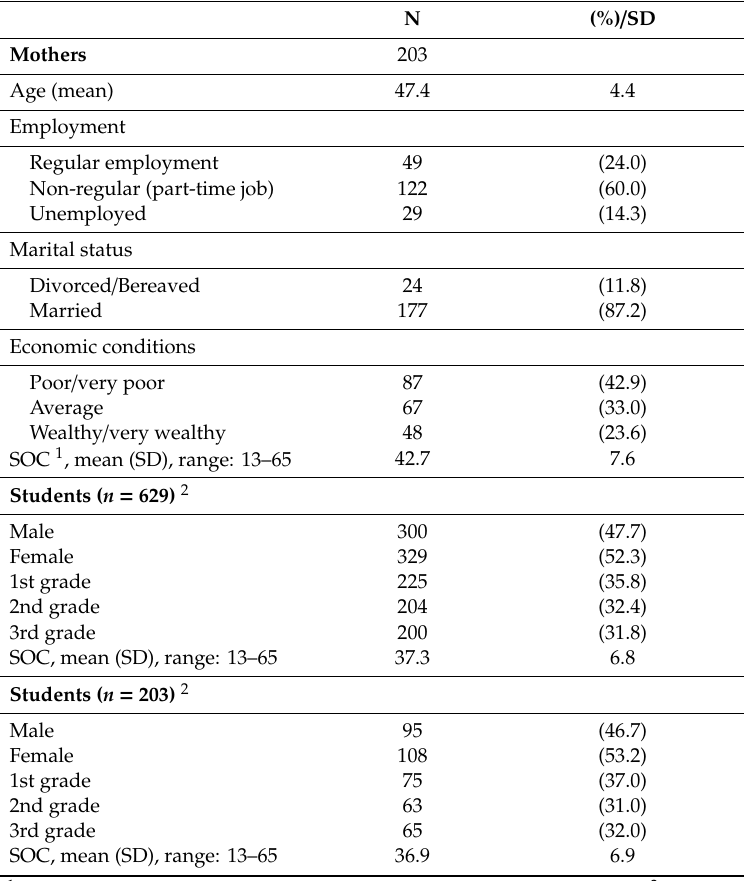
Table 1. Participants’